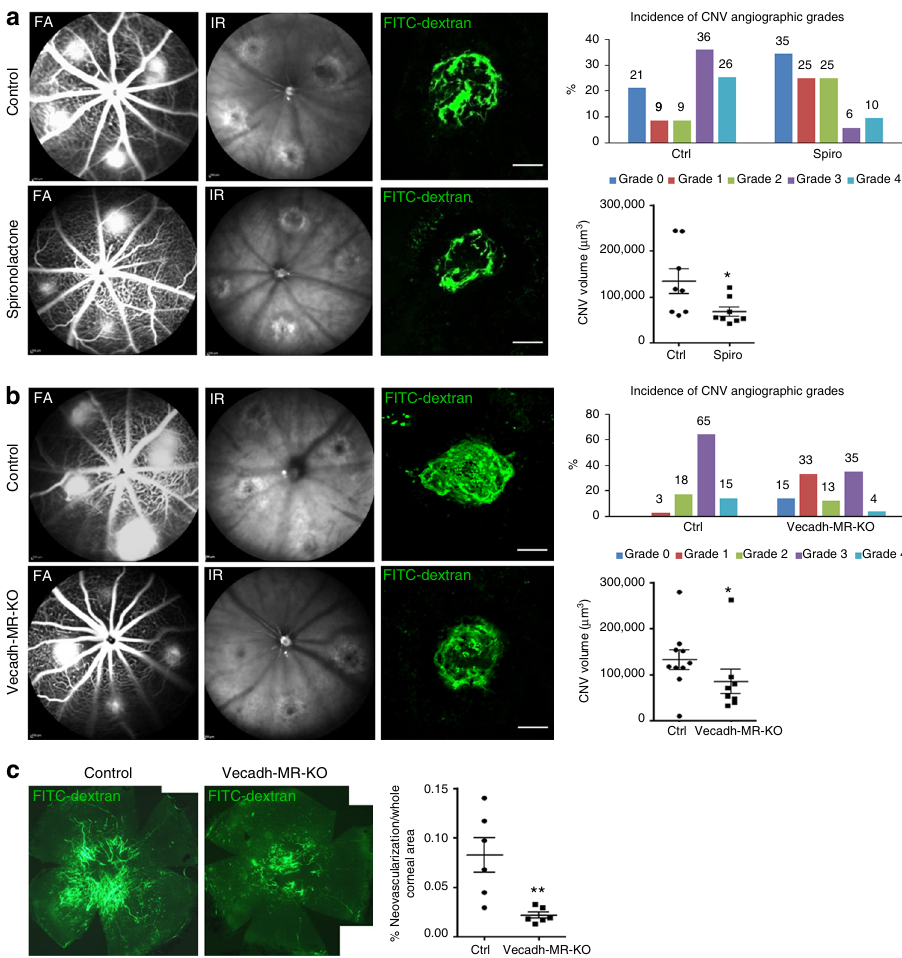
Fig. 3 Vascular endothelial MR contributes to CNV. a Systemic spironolactone signi fi cantly reduces CNV fl uorescein angiographic (FA) grades ( p < 0.001) as well as CNV volume ( p = 0.0348) as compared to control mice. CNV were labeled with FITC-dextran (green). Infrared (IR) images show up all the laser burns in the fundus. b Cell-type-speci fi c MR deletion from endothelial cells using the VE-Cadherin promoter (Vecadh-MR-KO) reduces CNV leakage on FA ( p = 0.0041) and decreases the volume of CNV labeled with FITC-dextran (green) in mice ( p = 0.0434). IR images show up all the laser burns. Bar: 100 µ m ( a , b ). FA Data are expressed as the incidence of CNV angiographic grades of the total laser impacts in each group. CNV volumes are expressed as mean ± SEM of the average CNV size per mouse. n represents the number of mice. Linear mixed model was used for statistical analyses. * p < 0.05. c In a model of corneal neovascularization using Vecadh-MR-KO mice, a reduction in corneal neovessels labeled with FITC-dextran was observed compared to control mice. Quanti fi cation of the neovascular surface on mosaic images con fi rms a signi fi cant decrease in the neovascularization/whole corneal area ratio in Vecadh-MR-KO mice. Data are expressed as mean ± SEM. n represents the number of mice. Non-parametric Mann – Whitney U- test was used. ** p <